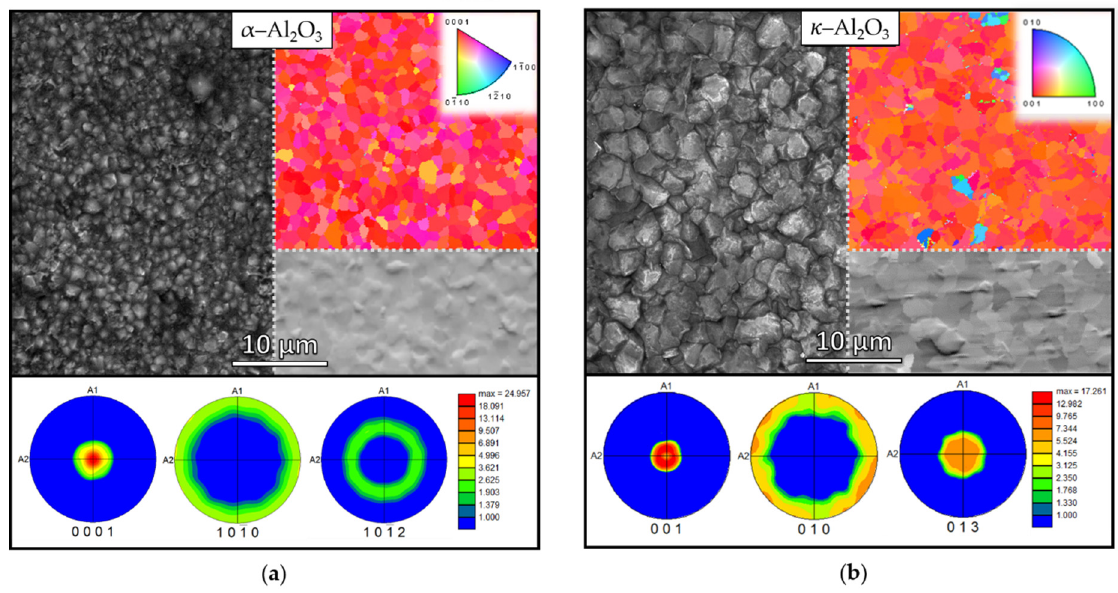
Figure 2. SEM images of the as-deposited coatings and IPF EBSD maps combined with the SEM images of the polished surfaces as well as the corresponding calculated EBSD pole figures of ( a ) α –Al 2 O 3 and ( b ) κ –Al 2 O 3 coatings.